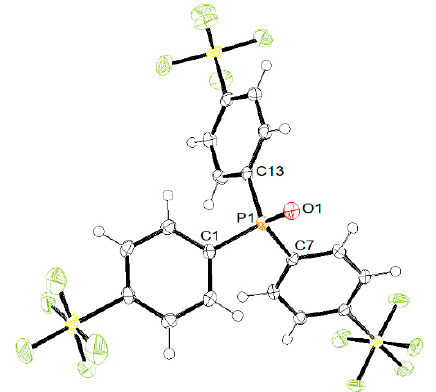
Figure 2. ORTEP representation of 2 with thermal ellipsoids drawn at 50% probability level. The two C 6 H 6 molecules contained in the asymmetric unit have been omitted for clarity. Selected bond lengths